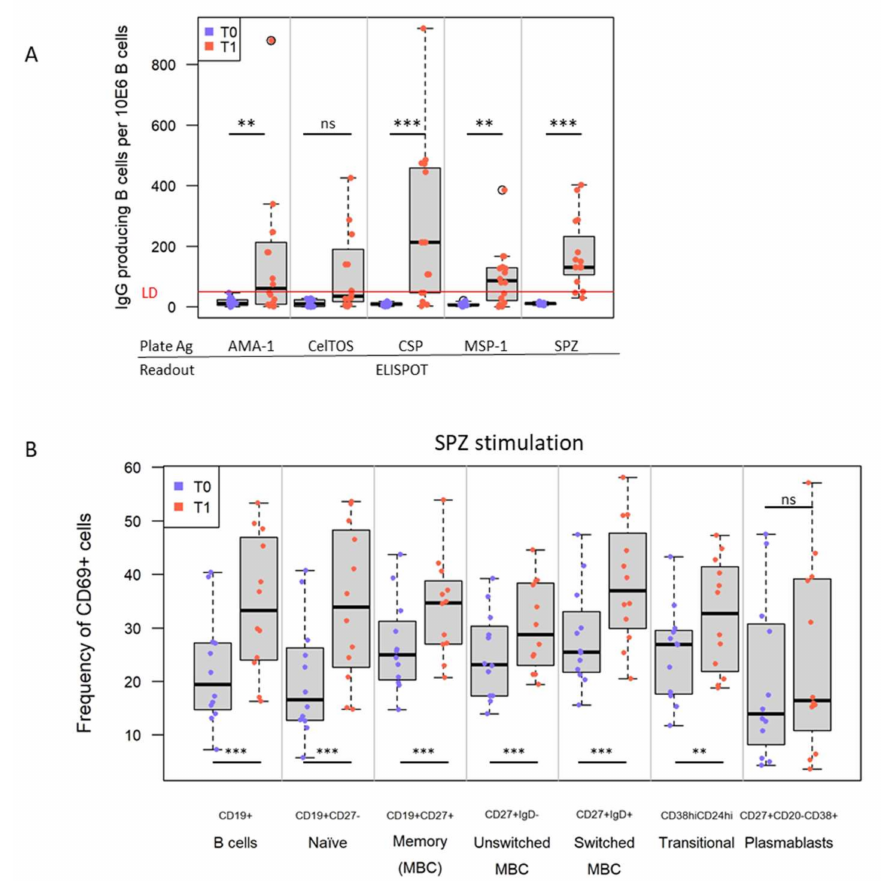
Figure 4. Frequency and composition of Plasmodium -specific reactive B cells before and after IMRAS immunization. ( A ) Antigen specificity (SPZ, CSP, CelTOS, AMA-1, and MSP-1) and frequency of Plasmodium -specific, IgG-producing B cells per million PBMC assessed by ELISpot. Box plots represent n = 16 subjects per time point. ( B ) Changes in the frequency and composition of SPZ-specific B cell compartment: naïve B cells, memory (MBC), switched MBC, un-switched MBC, transitional B cells, and plasmablasts (phenotypic markers indicated on X -axis) assessed by flow cytometry. Box plots represent n = 12 subjects per time point. ns = not significant, ** p < 0.01, *** p < 0.001. LD = limit of detection